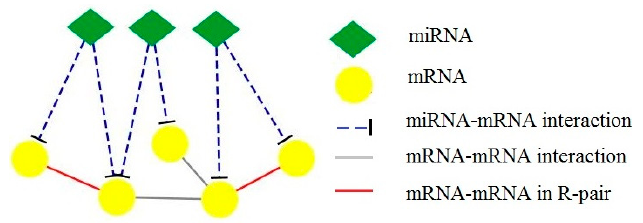
Figure 1. PPI, CR and R-pair. If two mRNAs are regulated by the same miRNA and there are also interactions between them, they form an R-pair.